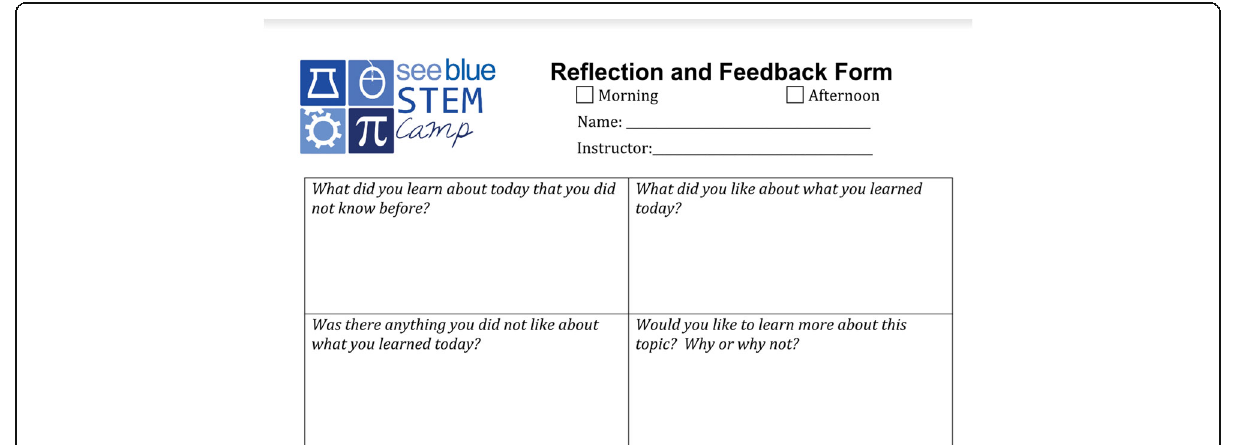
Fig. 1 Daily reflection and feedback form the students completed after each